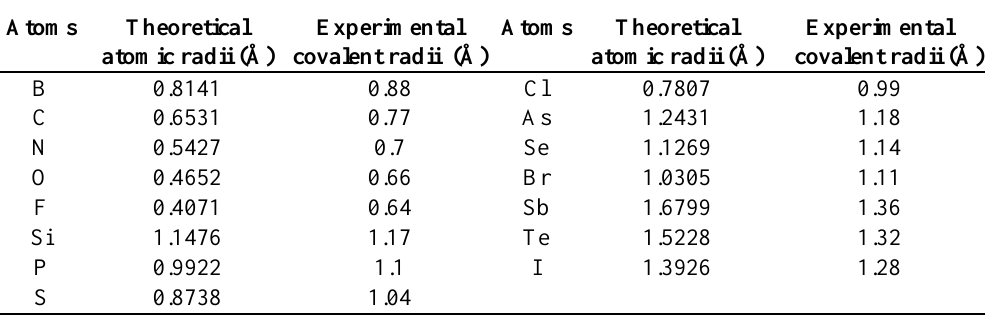
Table 5. Comparative study of theoretical radii and Pauling’s experimental covalent radii of atoms.